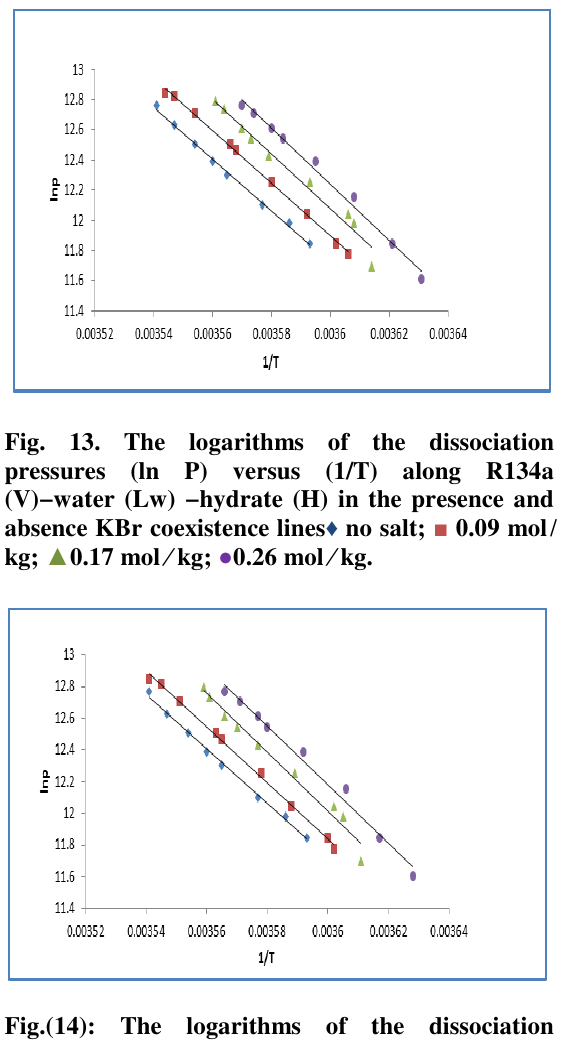
Fig.(14): The logarithms of the dissociation pressures (ln P) versus (1/T) along R134a(V)−water (Lw) −hydrate (H) in the presence and absence NaF coexistence lines ♦ without salt; ■ 0.09 mol ∕ kg; ▲ 0.17 mol ∕ kg; ● 0.26mol ∕ kg.